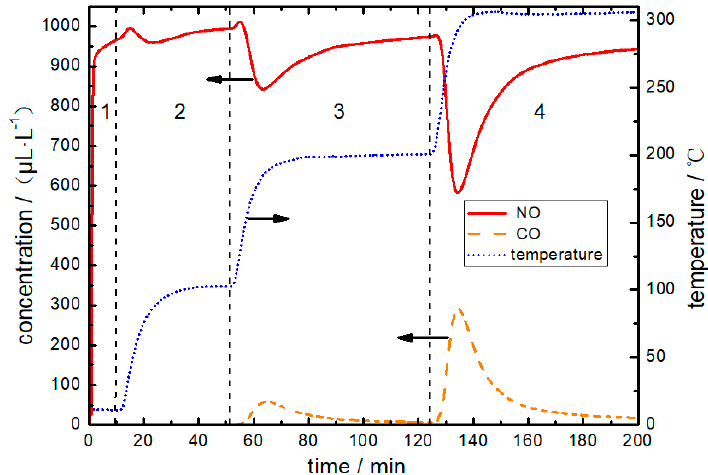
Figure 2. Effect of activated carbon in NO/N 2 system (1000 μ L/L NO). Figure 2. E ff ect of activated carbon in NO / N